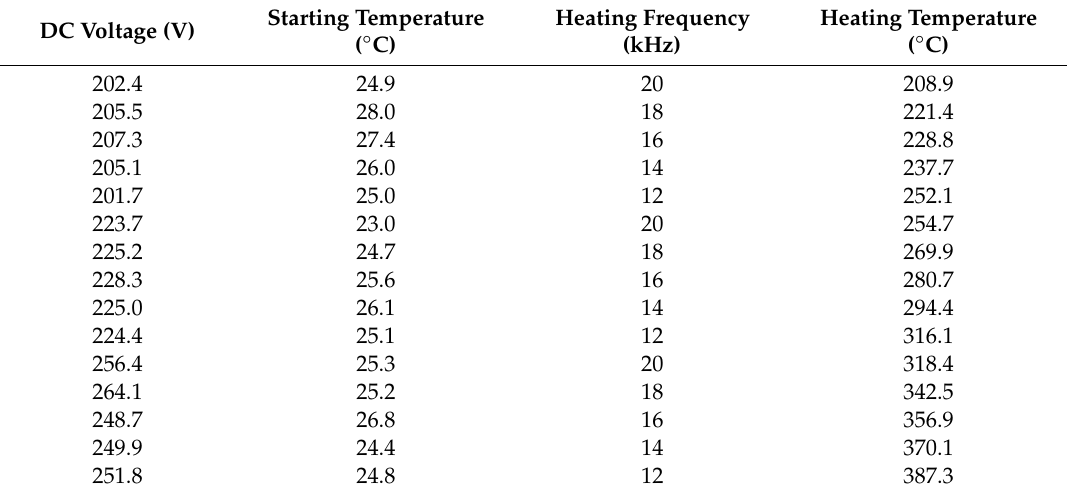
Table 2. Experimental results of the BT40-SF06 tool